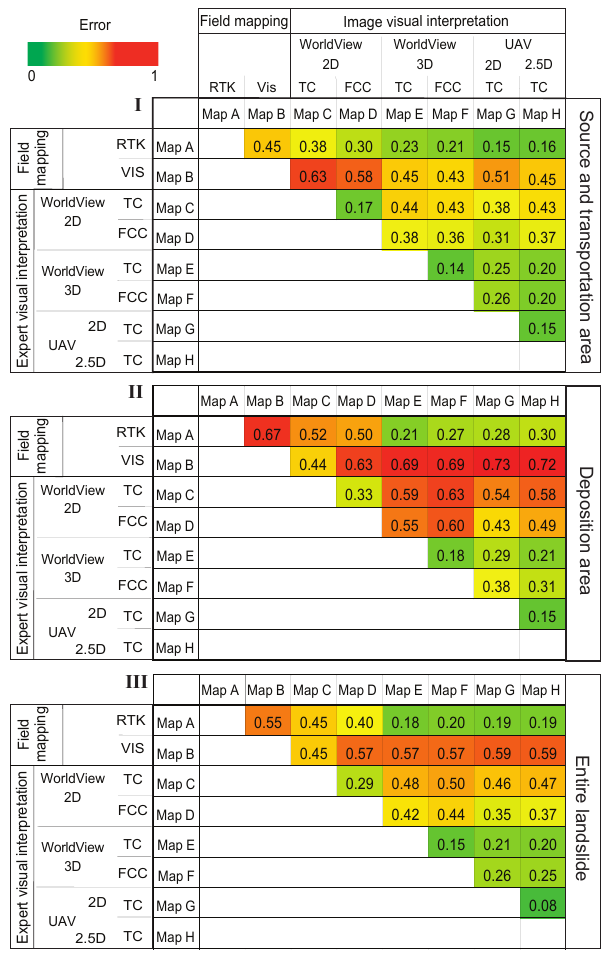
Figure 6. The error index ( E) proposed by Carrara et al. (992), was used to compare quantitatively the different landslide maps. (I) Error index matrix for the landslide source and transportation area. (II) Error index matrix for the landslide deposit. (III) Error matrix for the entire landslide. E spans the range from 0 (perfect matching) to 1 (complete